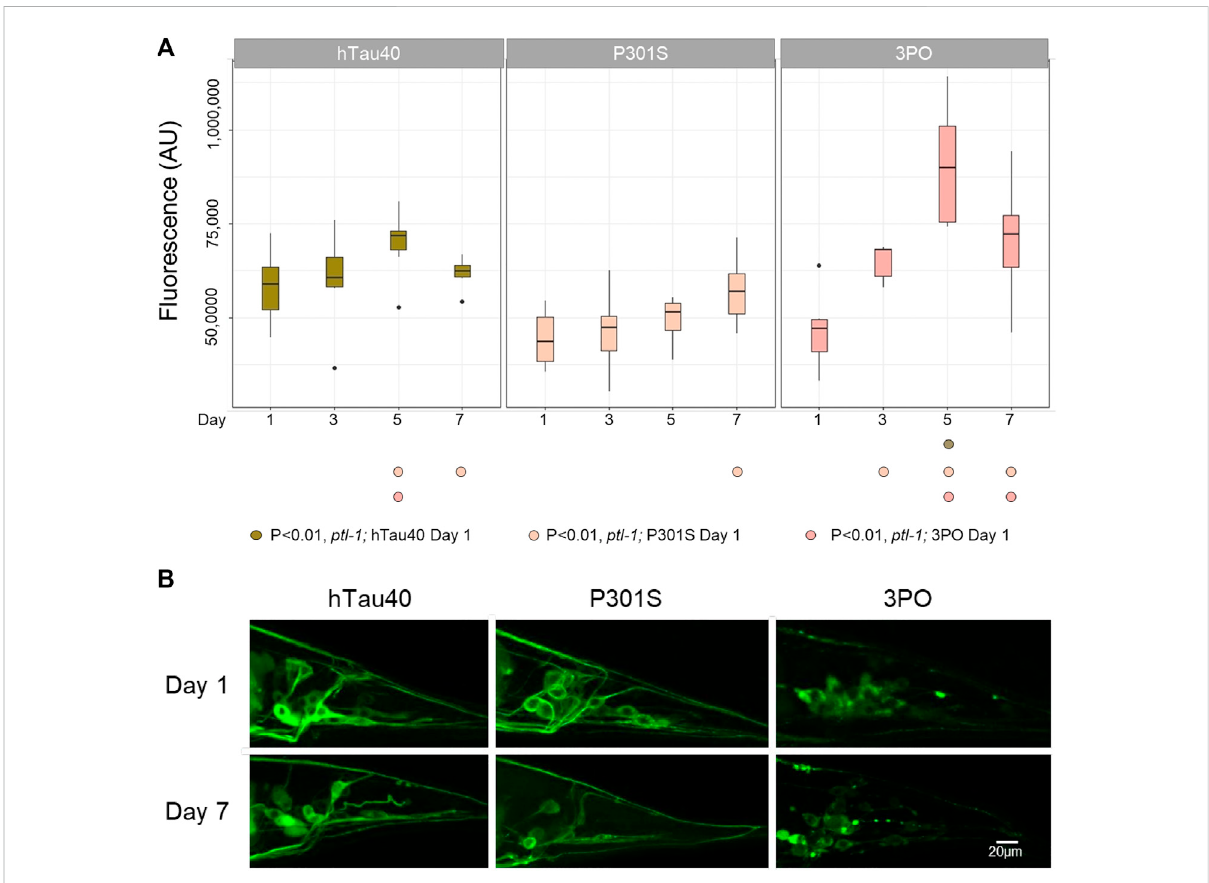
FIGURE 7 TauGFP variant accumulation in ptl-1 mutants. (A) . The ok621 mutation reduced the accumulation of P301SGFP that occurred in wild-type background, but not the increased stability of 3POGFP. ANOVA (Day*Variant) with Tukey post-hoc comparison. N = 10 for each sample. (B) . Representative images of GFP accumulation in ptl-1 mutants on days one and